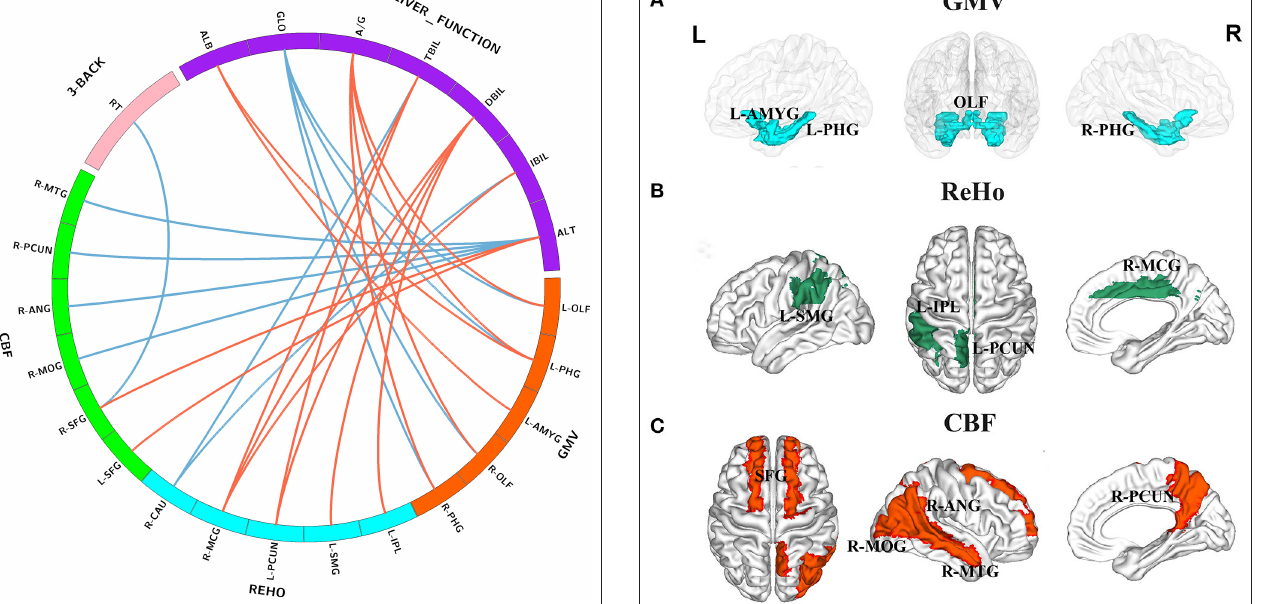
SFG (indirect effect = − 0.7209, SE = 0.4134, 95% CI: